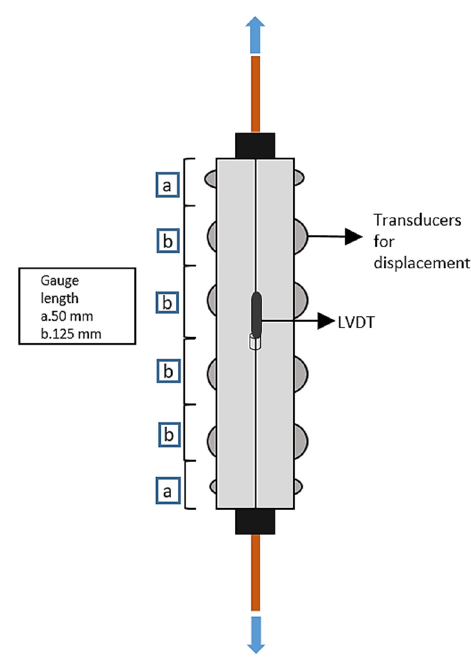
Figure 7. Push-in loading setup (adapted with permission from reference [57]).